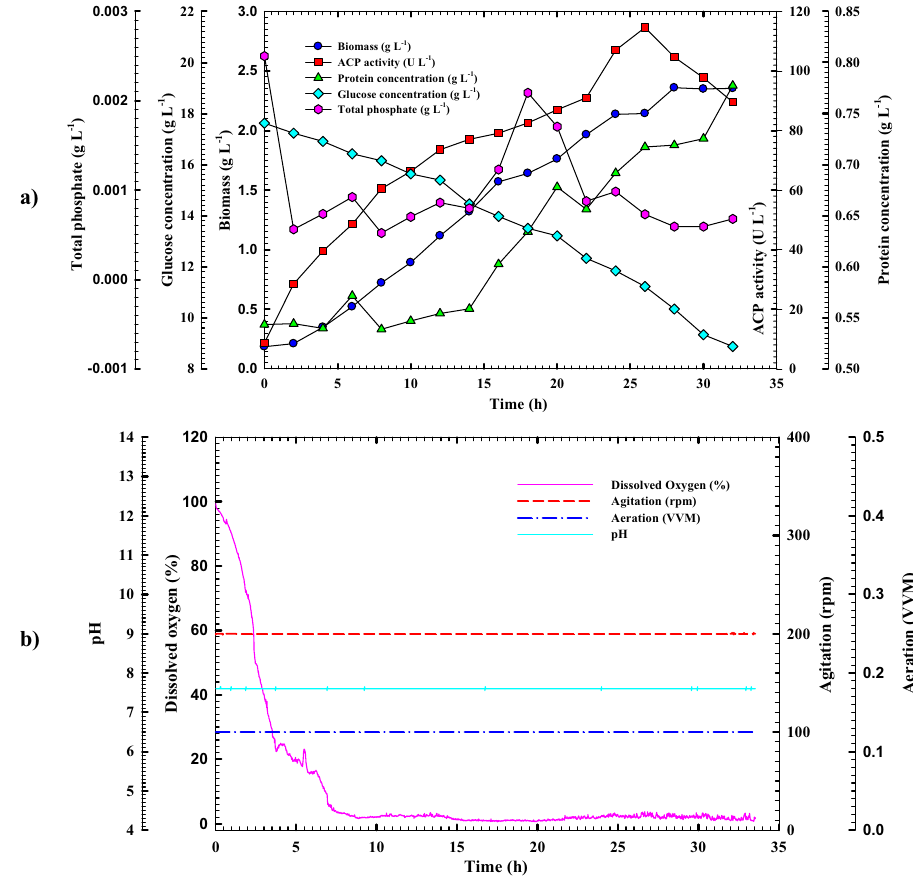
Figure 8. (a) Monitoring of B. haynesii strain ACP1 growth and ACP productivity in a 7 L stirred-tank bioreactor under controlled pH conditions, and (b) online data (DO, agitation, aeration, and pH) as a function of time during batch